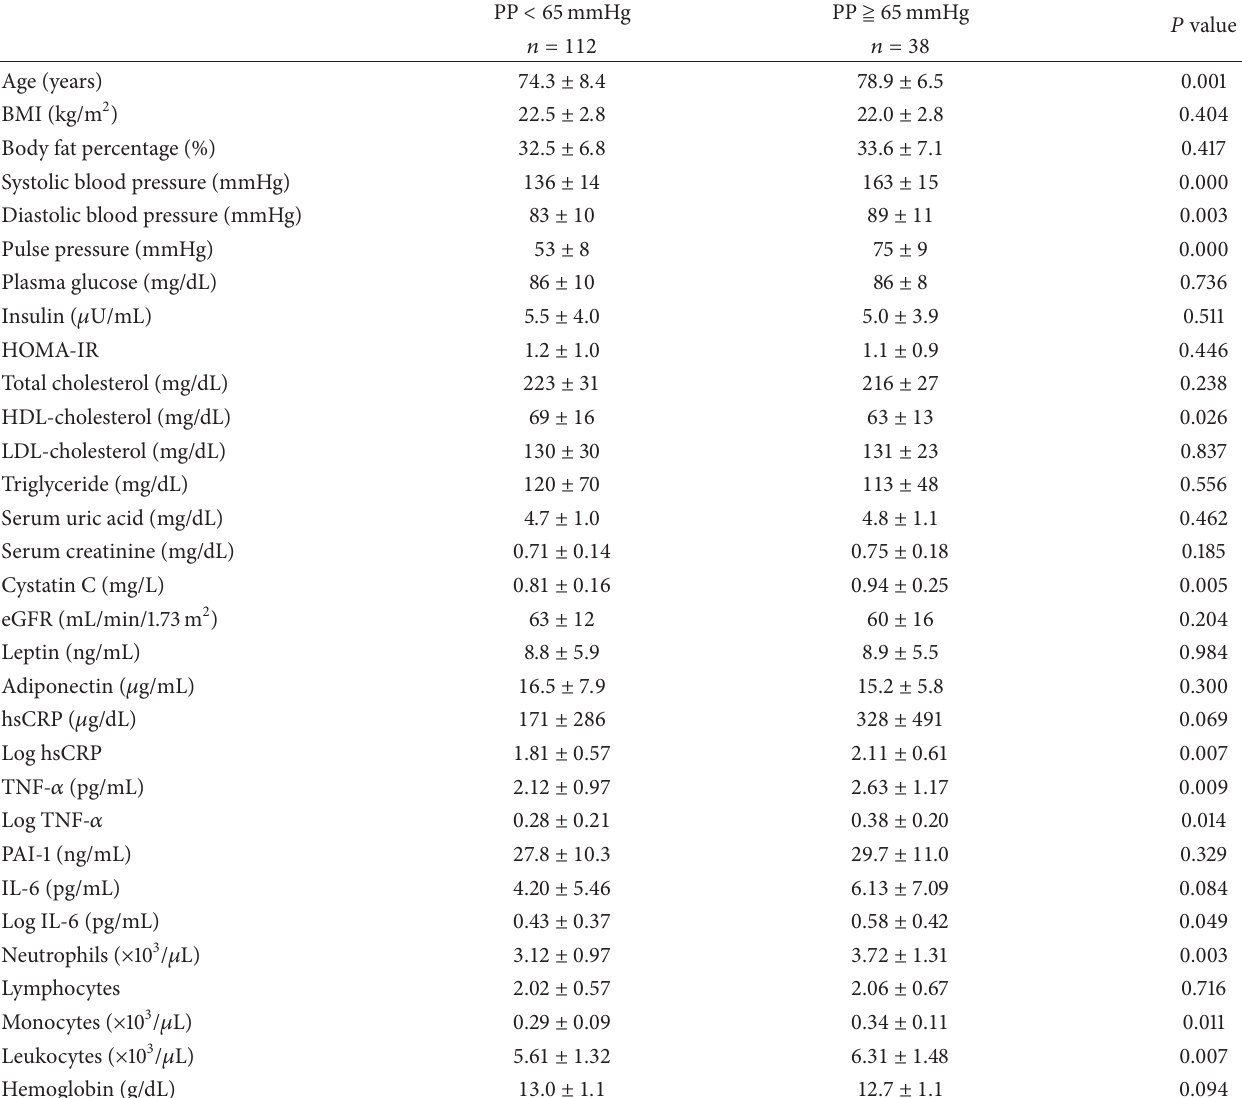
Table 3: Anthropometric, biochemical, and hematological characteristics of elderly women with high pulse pressure ( ≧